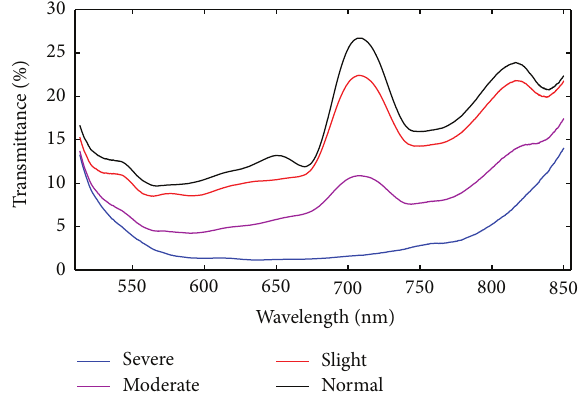
Figure 4: Average transmission spectra of potatoes with different blackheart